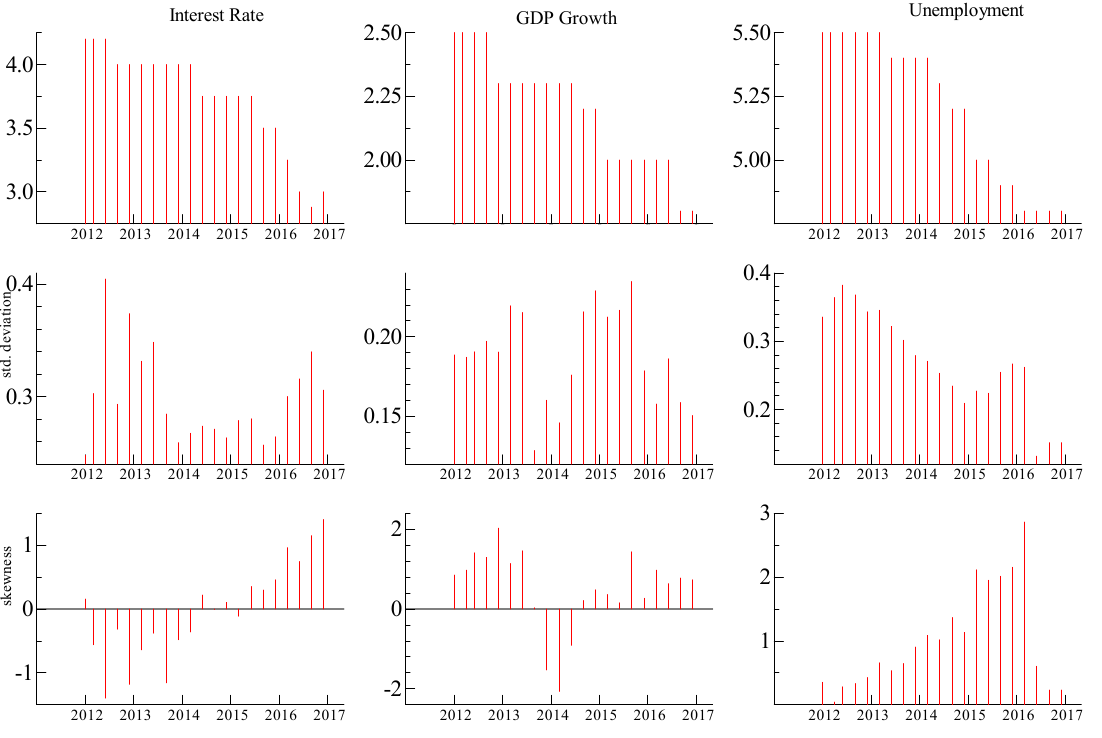
Figure 7. Medians ( top row ), standard deviations ( middle ), and skewness of marginal densities for forecasts of the longer Interest rate ( left ), GDP Growth ( center ), and Unemployment rate ( right )— January 2012–December 2016.